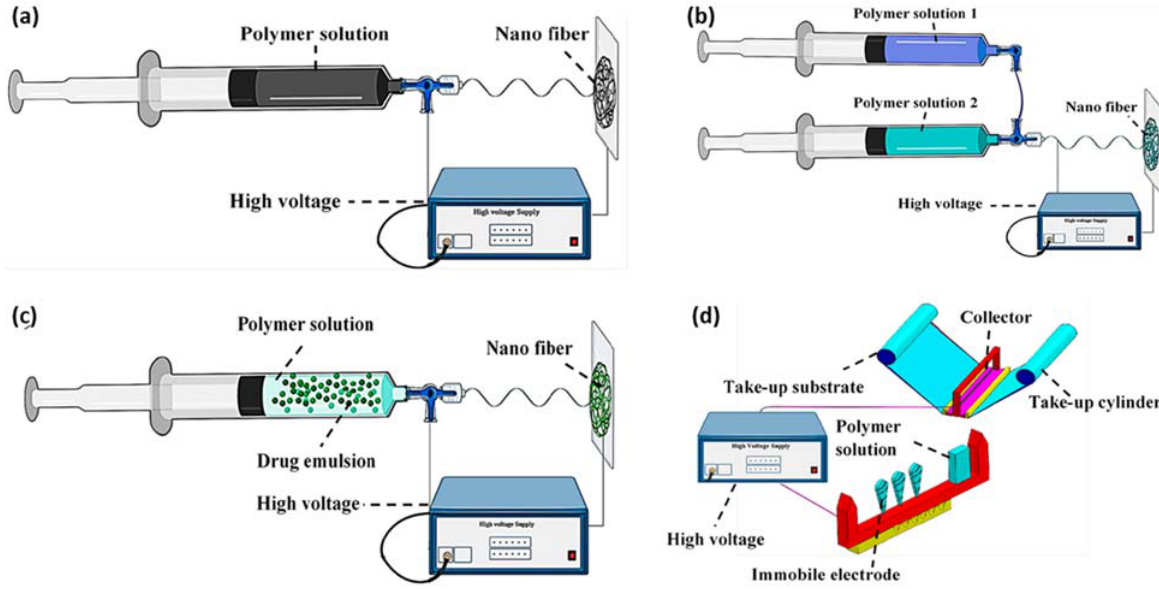
Figure 7. Electrospinning technologies ( a ) blend electrospinning, ( b ) coaxial electrospinning, ( c ) emulsion electrospinning, and ( d ) needleless electrospinning (reproduced from Ref. [67] with permission from the MDPI).